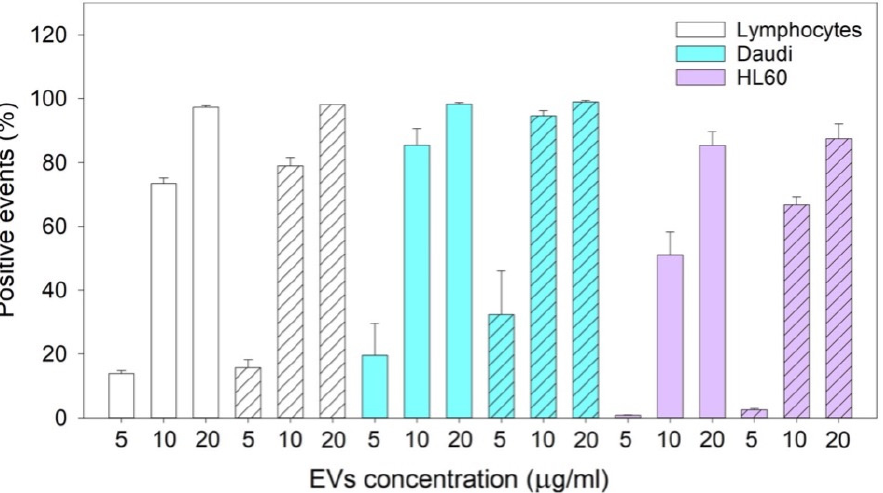
Figure 5. The graph bar represents the mean and the SE of the results of nEVs’ uptake in lymphocytes, Daudi, and HL60 cell lines at different concentrations (5, 10, and 20 µg/mL) at 24 (solid color bars) and 48 (dashed bars) hours. Plotted data are the mean ± SE. The comparisons between cell lines, times, and types of treatments were performed using the three-way ANOVA test, and the statistical significance is reported in the main text. Independent experiments were carried out two times.